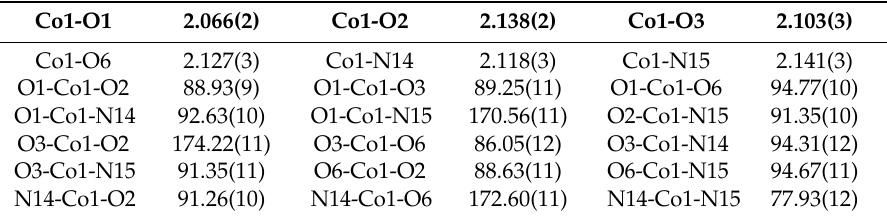
Table 2. Selected bond lengths (Å) and angles ( · ) for complex 1